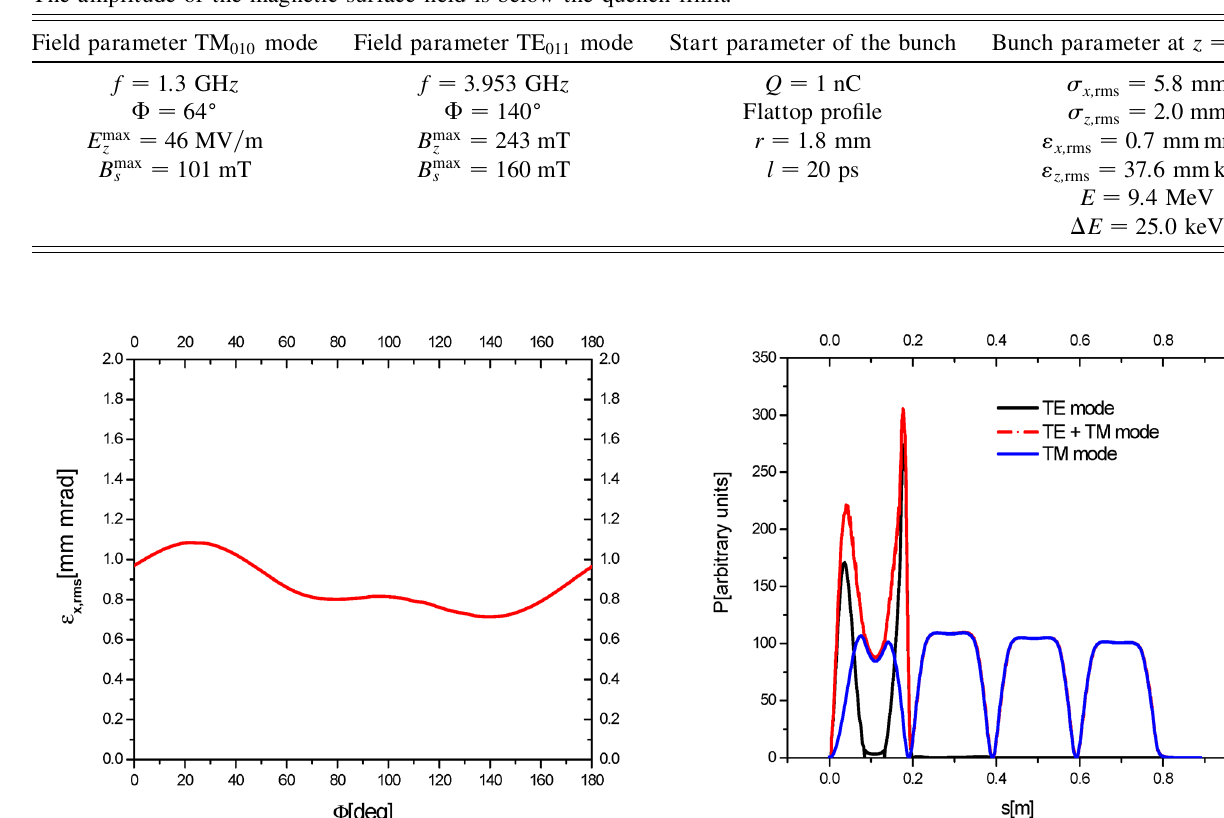
surface.FIG. 7. (Color) Dependence of the transverse emittance on the phase of the TE mode. B max